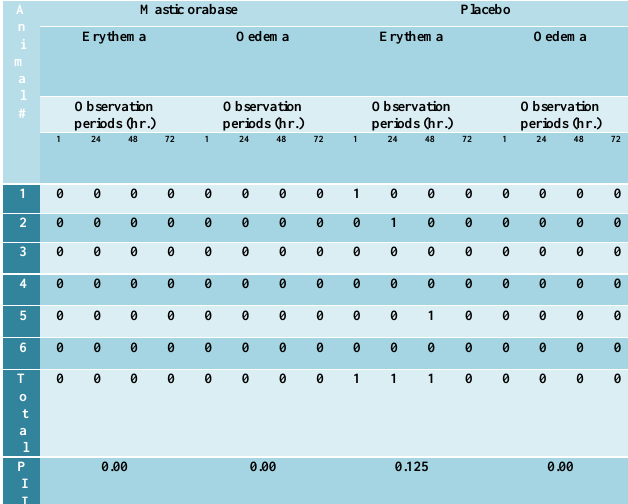
Table 1: primary skin irritation test of six rabbits observed at 1, 24, 48, and 72